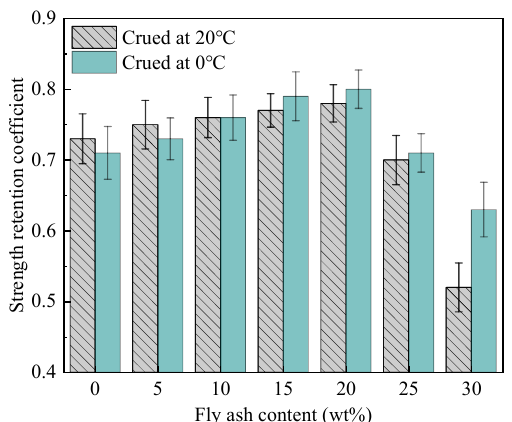
Figure 6. The variation of water resistance with mixing temperature and fly ash content .